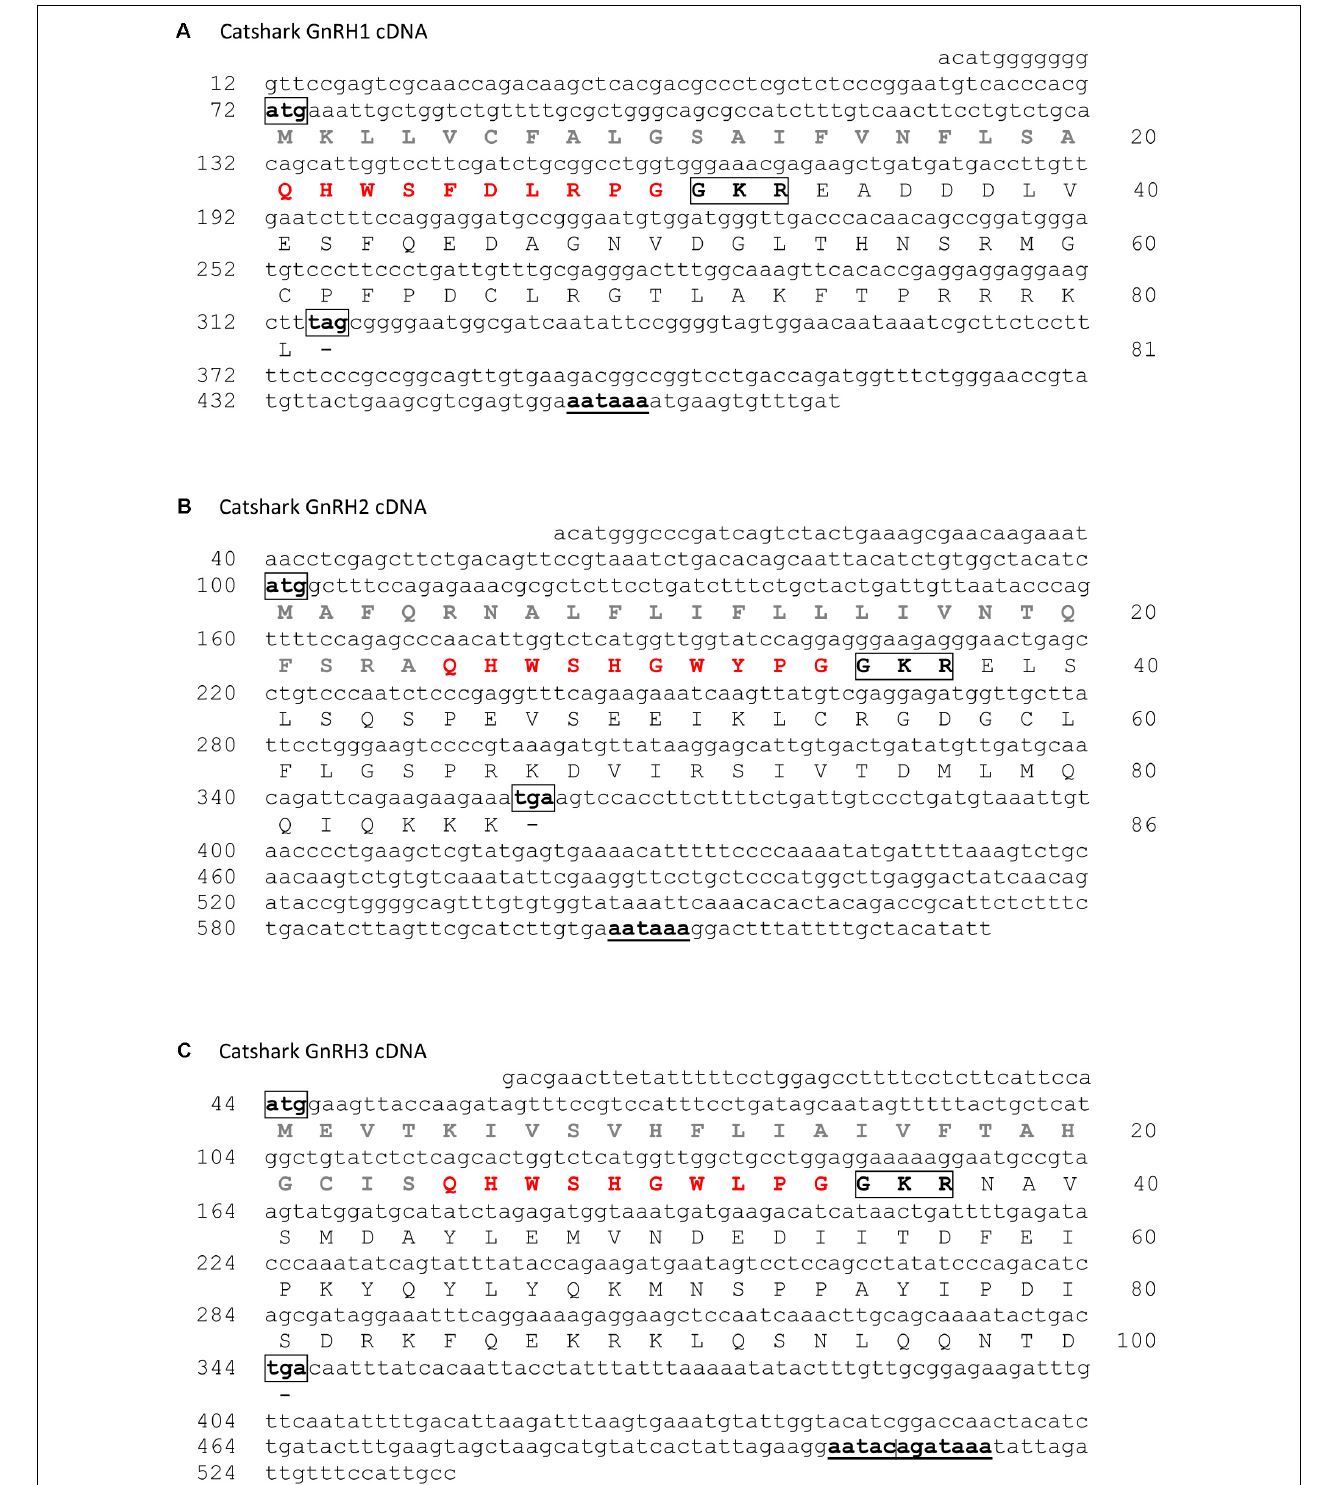
FIGURE 1 | Nucleotide sequence and deduced amino acid sequence of catshark GnRH1 (A) , GnRH2 (B) , and GnRH3 (C) cDNAs. Nucleotides are numbered 5 (cid:48) to 3 (cid:48) and amino acids N-terminal to C-terminal from the putative starting methionine. Signal peptides are in gray. GnRH peptide sequences are in red. Potential cleavage sites are boxed. Polyadenylation signals are underlined. Sequences of catshark GnRH1 , GnRH2, and GnRH3 cDNAs have been deposited in the GenBank data base under the accession numbers MH468810, MH468811, and MH468812, respectively. ND, not determined.